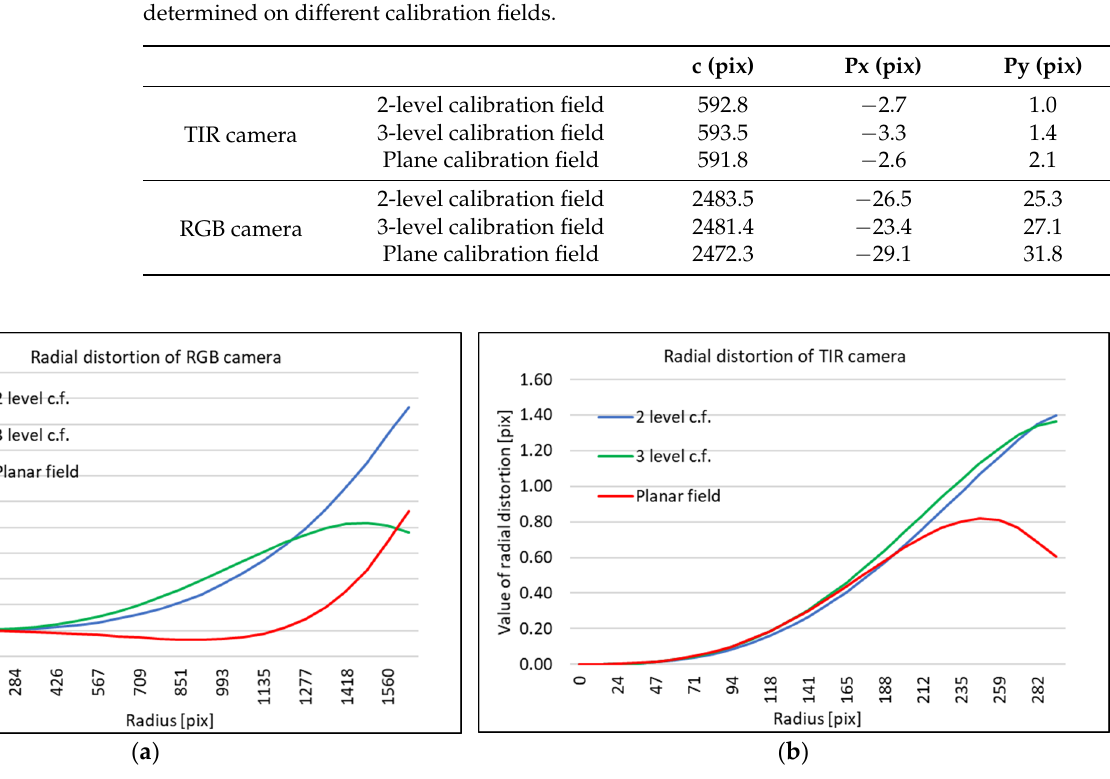
Figure 10. Radial distortion determined by camera calibration using different calibration fields: ( a ) RGB camera ( b ) TIR camera. Table 4. The resulting interior orientations of the TIR camera and the RGB camera of FLIR E95, determined on different calibration fields.